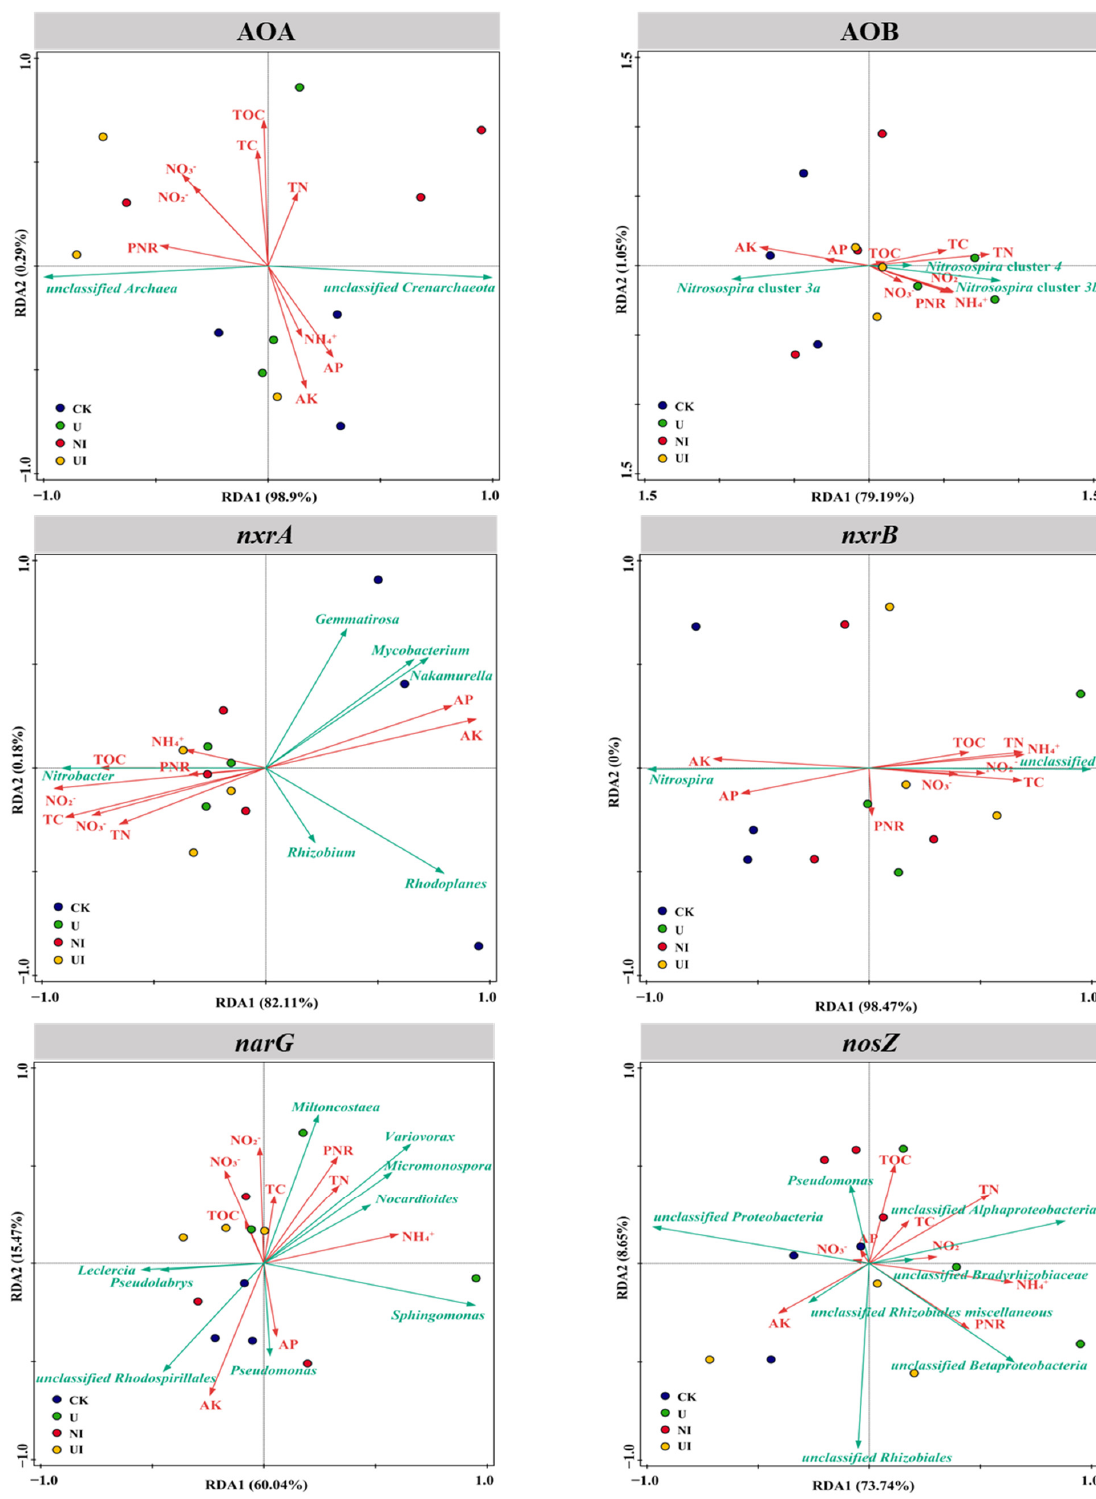
Figure 5. Redundancy analysis (RDA) illustrating the relationship between environmental variables and the main genera of AOA, AOB, nxrA -bearing, nxrB -bearing, narG -bearing, and nosZ -bearing bacterial populations. The red arrows indicate different environmental factors. The green arrows indicate different genera. PNR: potential nitrification rates; TC: total soil carbon; TN: total soil nitrogen; TOC: total soil organic carbon; AP: available soil phosphorus; AK: available soil potassium; NH 4 + : ammonium nitrogen; NO 2 − : nitrite nitrogen; and NO 3 − : nitrate